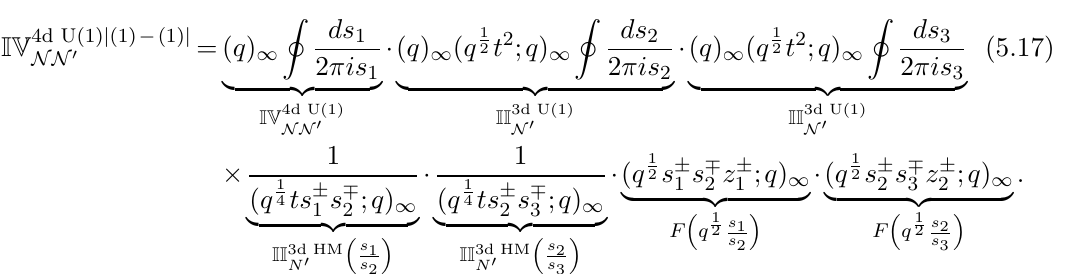
Figure 12 . The brane constructions of the 4d U( N ) and its mirror corner configuration that has no gauge N (cid:30)